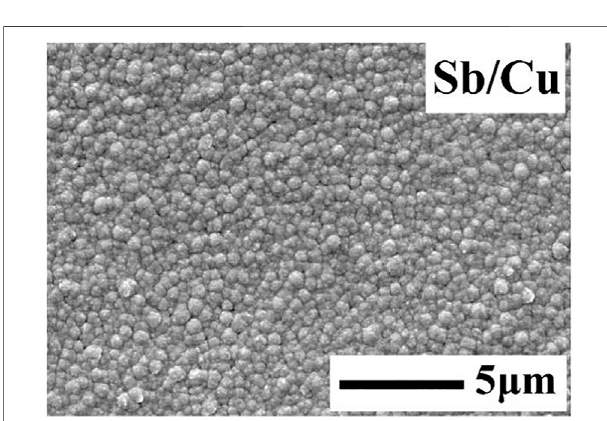
FIGURE 3 | SEM image of the Mo/Sb/Cu